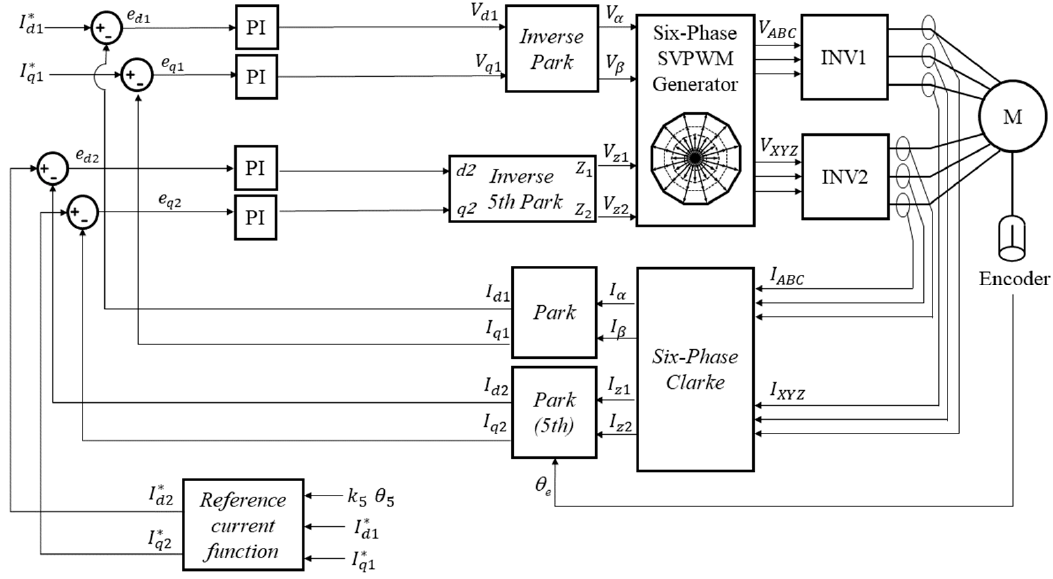
Figure 10. Current control scheme based on VSD with the fifth-harmonic injection method.